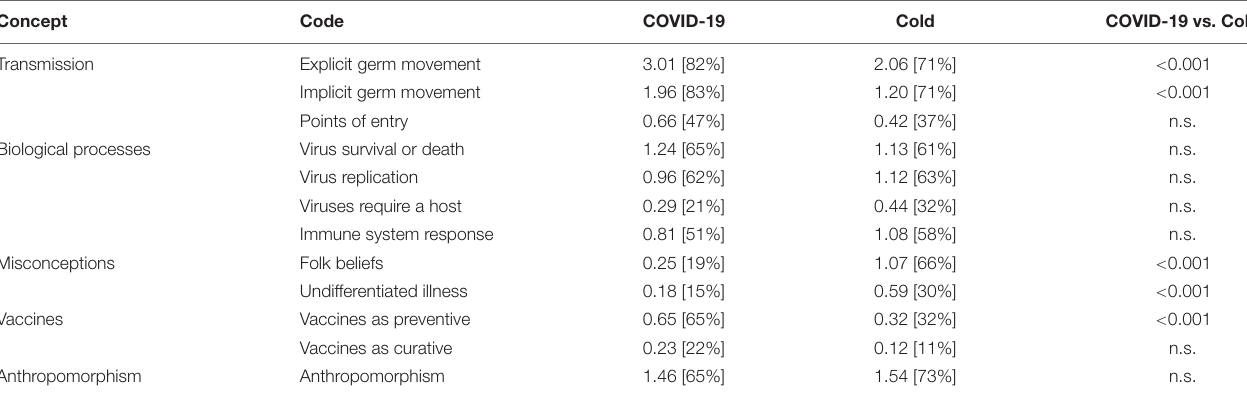
TABLE 4 | Qualitative coding, mean # of responses receiving each code, with % of participants providing at least one code in brackets.